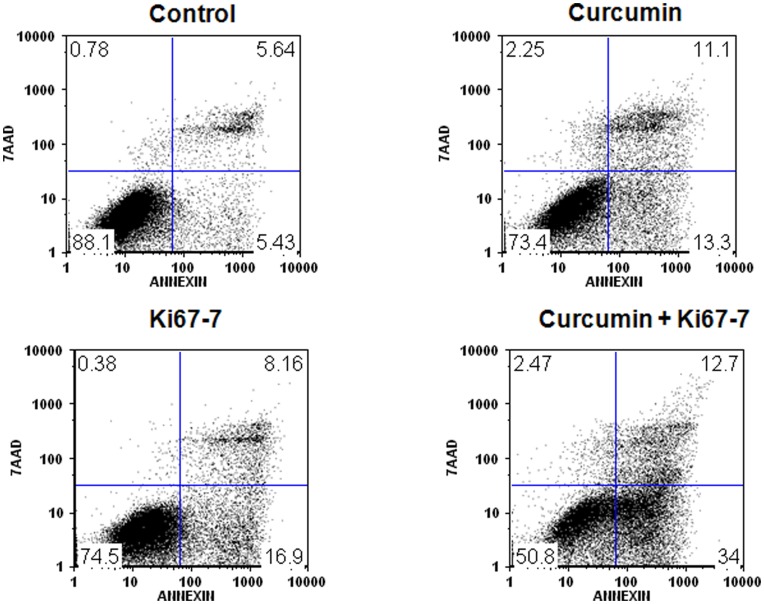
Determination of Ki-67-7 and curcumin-induced apoptosis by flow cytometry.AY-27 cells were treated with anti-Ki-67 siRNA, curcumin or in the combined presence of both as described in legend to Figures 3A and 3B. At the end of the treatment period, the cells were harvested, stained with fluorescence-conjugated Annexin V and 7AAD as described in Methods. Following flow cytometric analysis, the percentage (number inserts in the figure) of normal cells or those undergoing apoptosis and necrosis was calculated using appropriate software (Flow Jo v.9). The rate of apoptosis was measured by adding the percentages in the right two quadrants in each of the figures. The data are from a representative (of two identical) experiment.